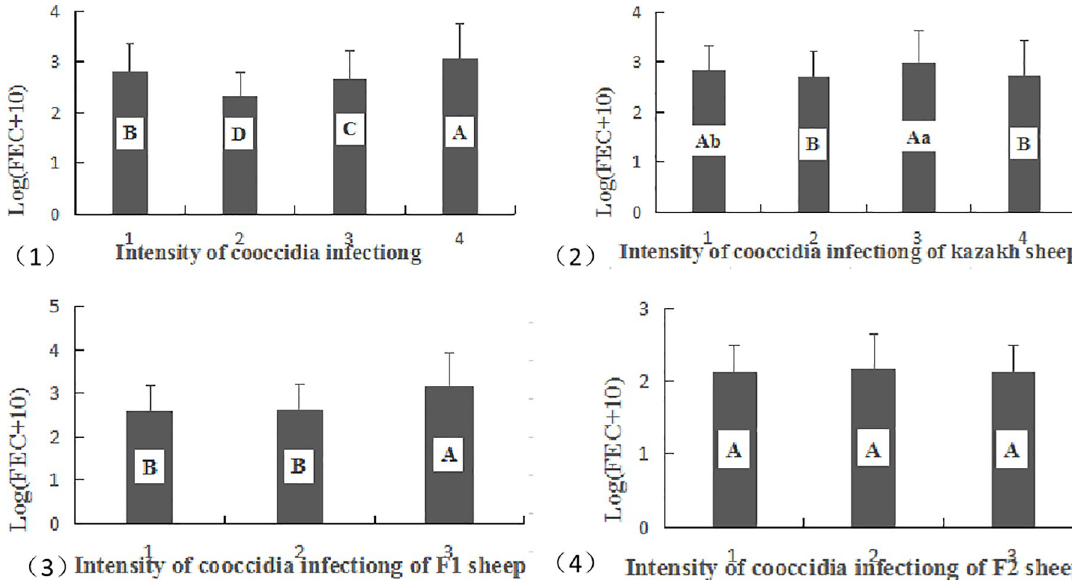
Fig 4. Correlation between GIN and coccidia infections in different sheep populations. Data in the same line, without the same uppercase superscripts (A–C) indicate a highly significant difference ( P < 0 . 001 ), without the same lowercase superscripts (a–c) differ significantly ( P < 0 . 05